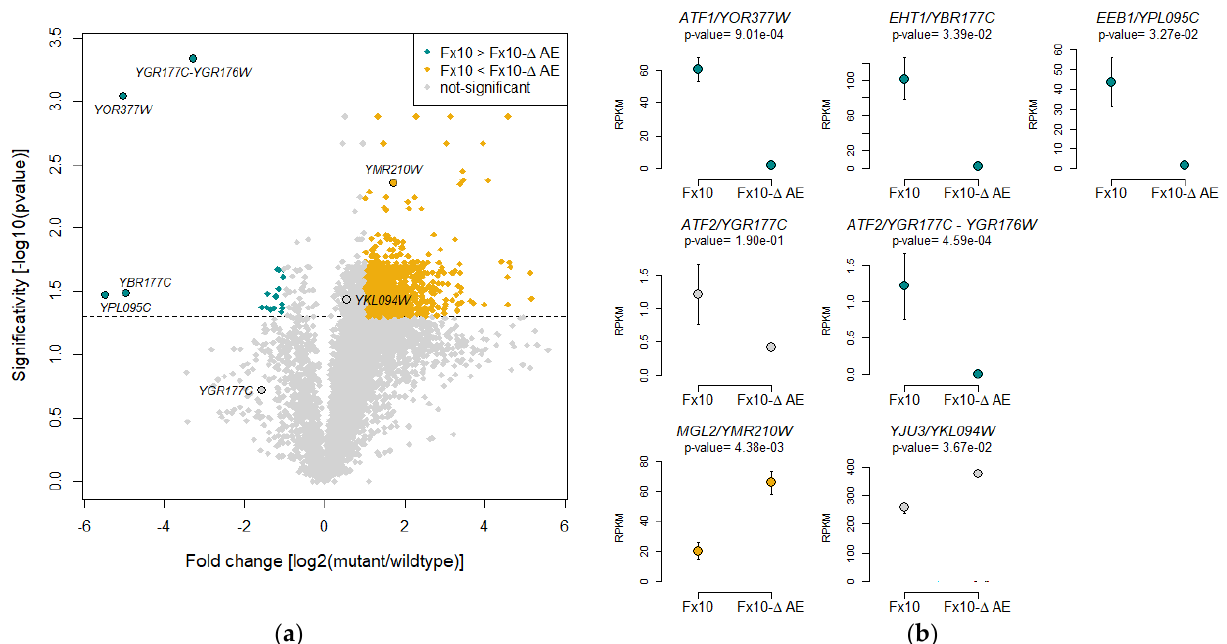
Figure 6. RNA-seq analysis of the Fx10- Δ AE mutant. ( a ) Volcano plot showing differentially expressed genes in the Fx10- Δ AE mutant compared to the Fx10 wildtype strain. A total of 6287 genes were considered, of which 1124 were DEGs. Yellow and blue-green dots show the 22 and 1102 genes downregulated or upregulated in the mutant, respectively. Gray dots represent the 5163 non-significant genes. ( b ) Expression patterns for genes of interest in the Fx10 wildtype and the Fx10- Δ AE mutant. RPKM stands for reads per kilobase million. Error bars represent standard errors. P-values were cor- rected for False Discovery Rate (FDR) multiple tests.